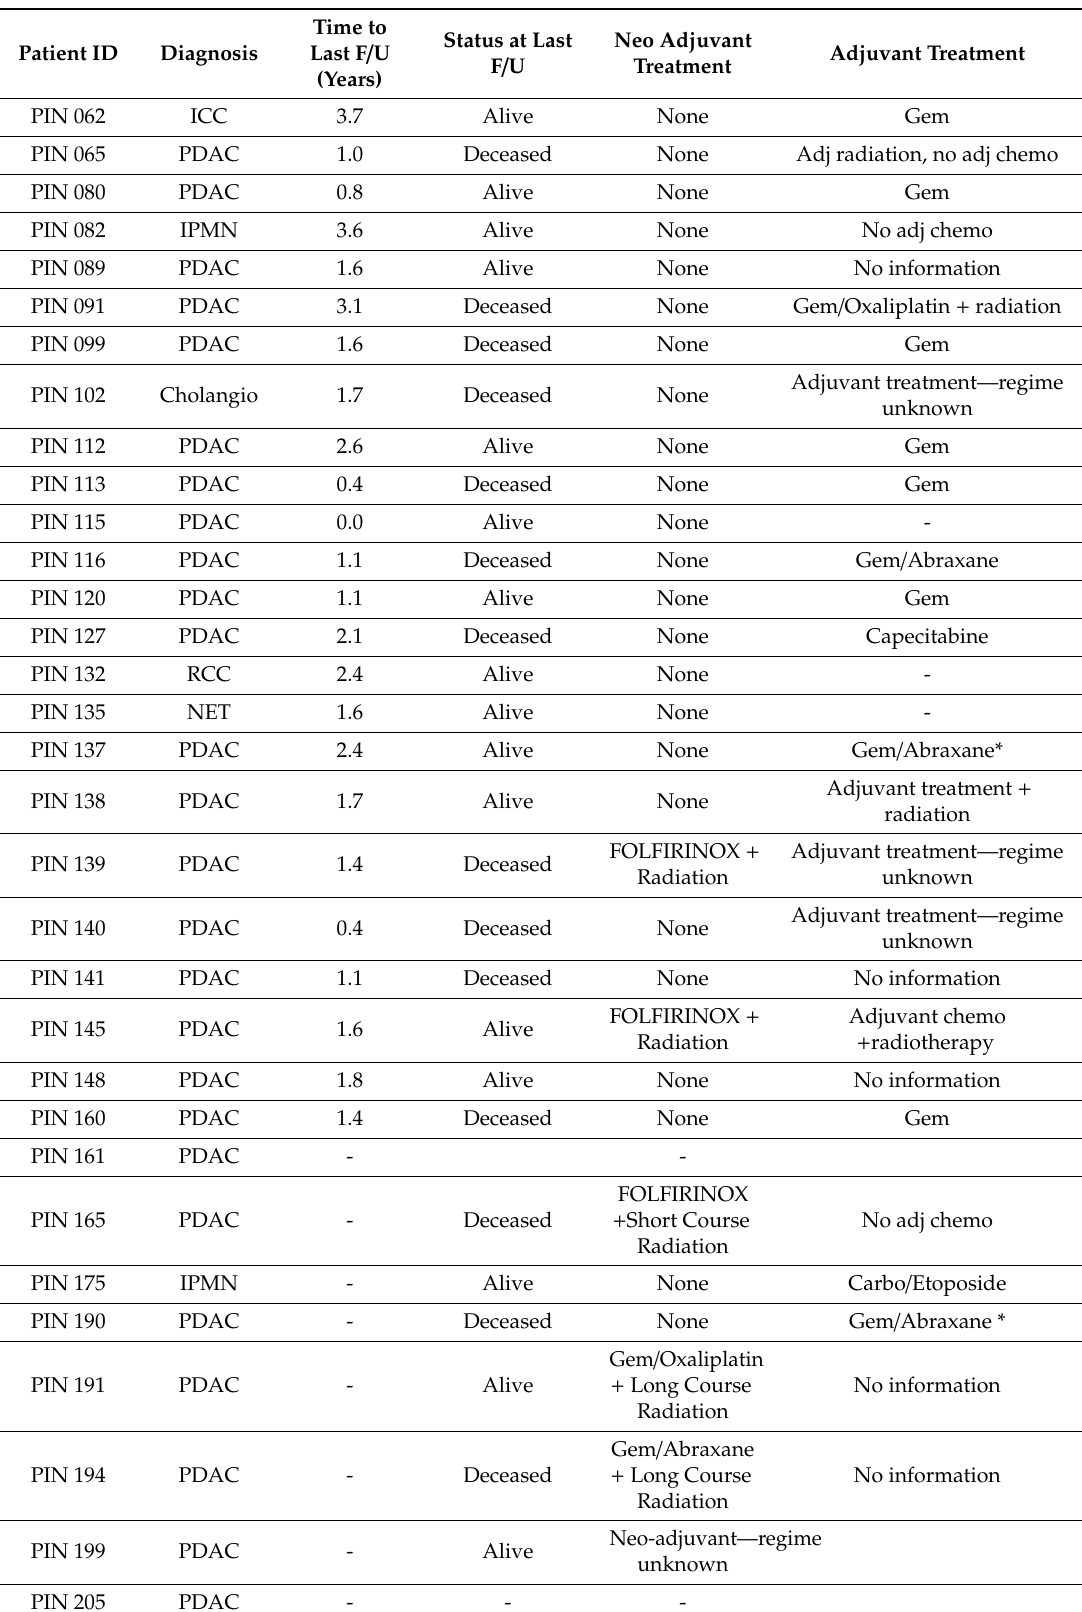
Table 2. Patient survival and treatment